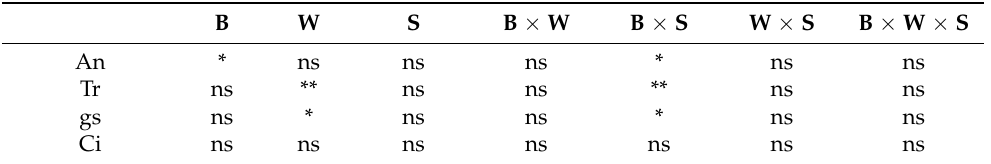
Note: * and ** indicate significance levels at p < 0.05 and p < 0.01; ns indicates there is no significantly effect at p <